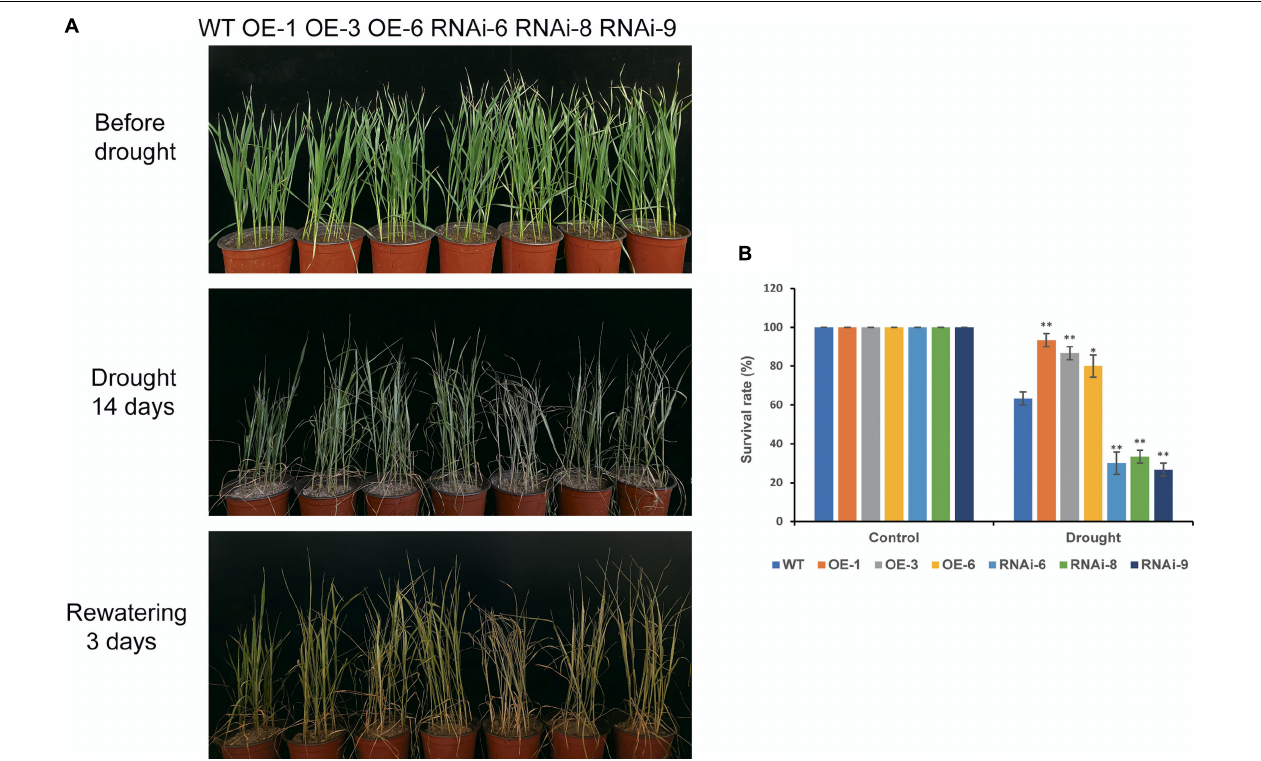
FIGURE 3 | Phenotype and survival rate of WT and TaNRX1 transgenic wheat under drought stress at the seedling stage. (A) WT and TaNRX1 transgenic wheat phenotype at 4 weeks, after 14 days drought treatment, and 3 days rewatering. (B) Survival rate ( n = 6). Data represent the mean ± SD. WT, wild type; OE-1–OE-6, TaNRX1 overexpression T 3 homogeneous lines; RNAi-6–RNAi-9, TaNRX1 RNA interference T 3 homogeneous lines. * P < 0.05, ** P < 0.01 represent the significant difference between the transgenic line and the WT, respectively.